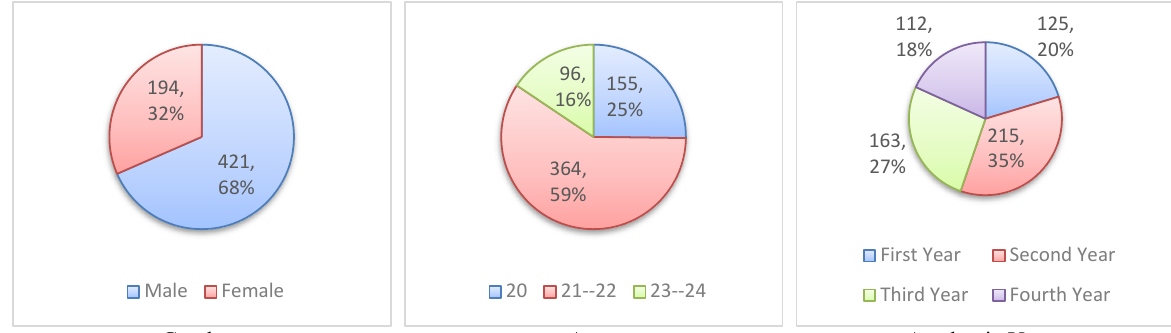
Fig. 1. Frequencies and percentages for the characteristics of the study